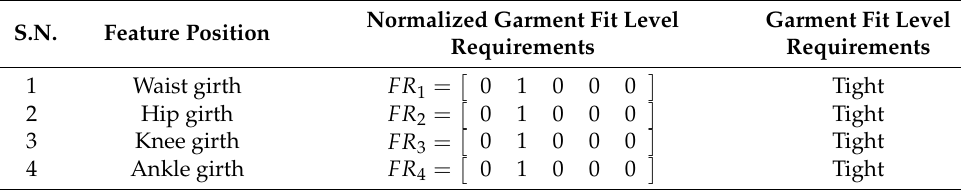
Table 2. The requirements of garment fit levels at feature positions FR